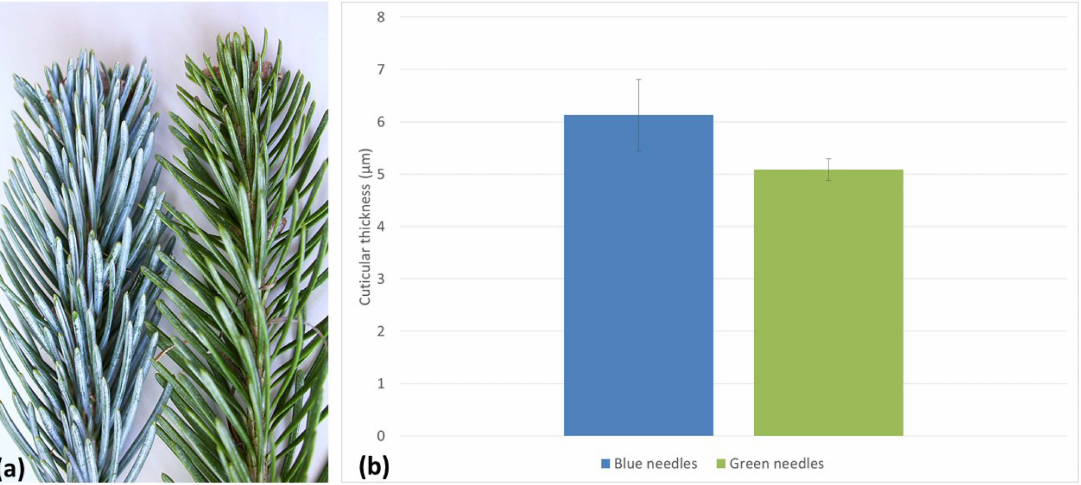
Figure 10. Results from measurements of cuticle thickness of needles from subalpine fir ( Abies lasiocarpa ) at Jønsberg. ( a ) The blue and green needles that were examined by electron microscopy; ( b ) mean cuticular thickness ( µ m) based on twelve measurements from each of seven green and seven blue needles. Photo: Venche